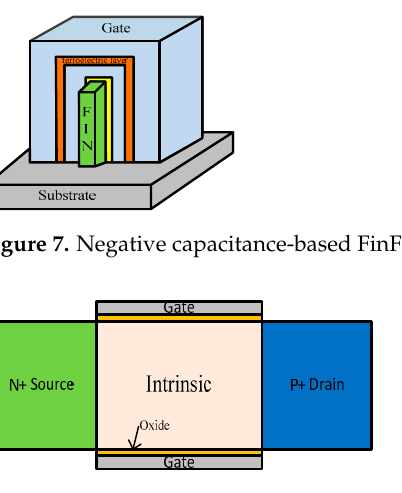
Figure 8. TFET structure: a cross-section showing doping levels [41].